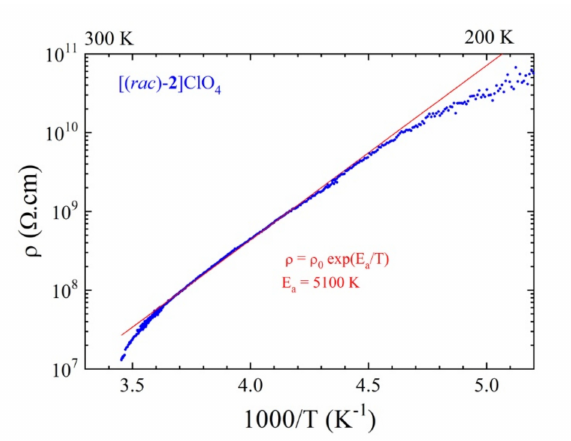
Figure 6. Temperature dependence of the electrical resistivity, ρ , plotted as log ρ versus 1000 / T for a single crystal of [( rac )- 2 ]ClO 4 measured using two contacts. The red line is the linear fit to the data giving the activation